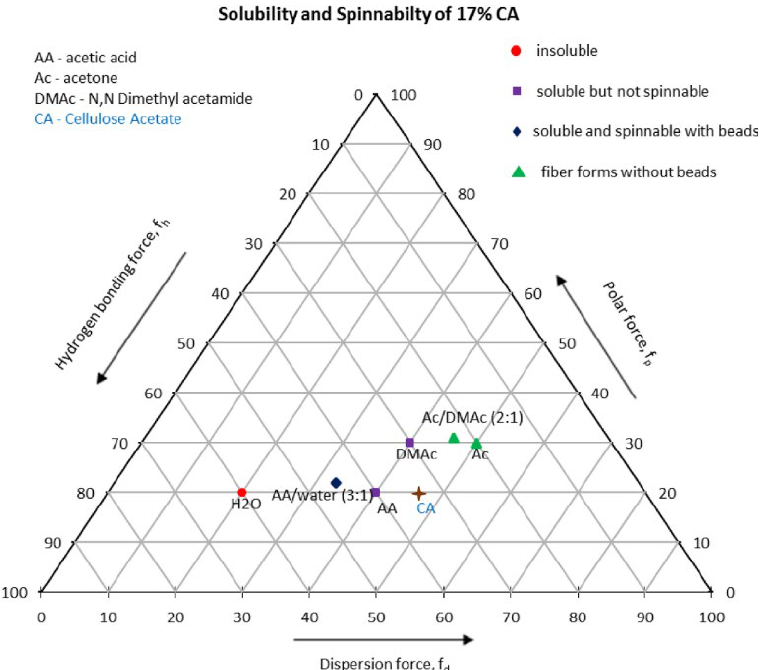
Figure 6. SEM images of 5% polycaprolactone solutions dissolved in various solvents: ( a ) glacial acetic acid, ( b ) 90% acetic acid, ( c ) methylene chloride/DMF = 4/1, ( d ) glacial formic acid, ( e ) and formic acid/acetone, along with ( f ) SEM images of polyvinyl butyral nanofibers prepared from 10 wt.% tetrahydrofuran/dimethyl sulfoxide (9/1 v / v ). Reproduced from reference [92] with permission from Elsevier and Arabian Journal of Chemistry.